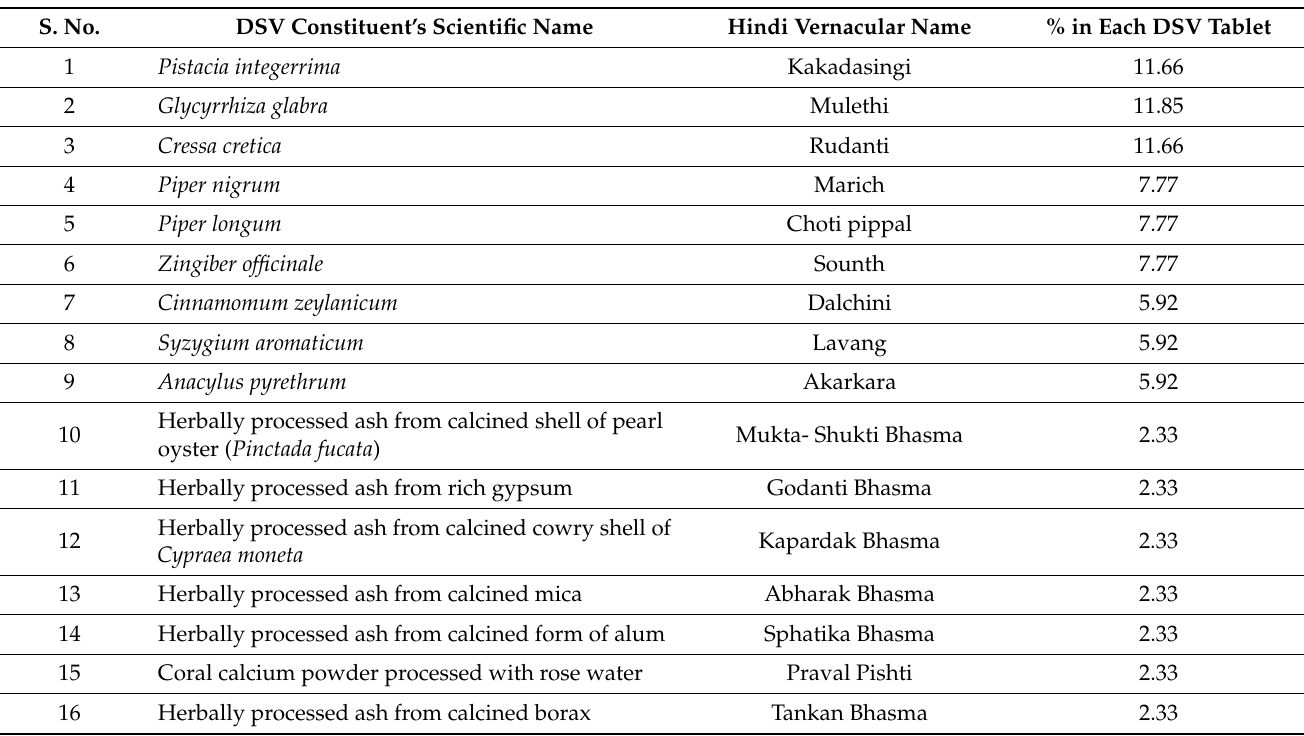
Table 1. Ingredients and Composition of Divya-Swasari-Vati (DSV) tablet formulation. Excipients: gum acacia ( Acacia arabica ) 4.62%, hydrated magnesium silicate 1.38% and colloidal silicon dioxide 1.38% are also present in the formulation. S.